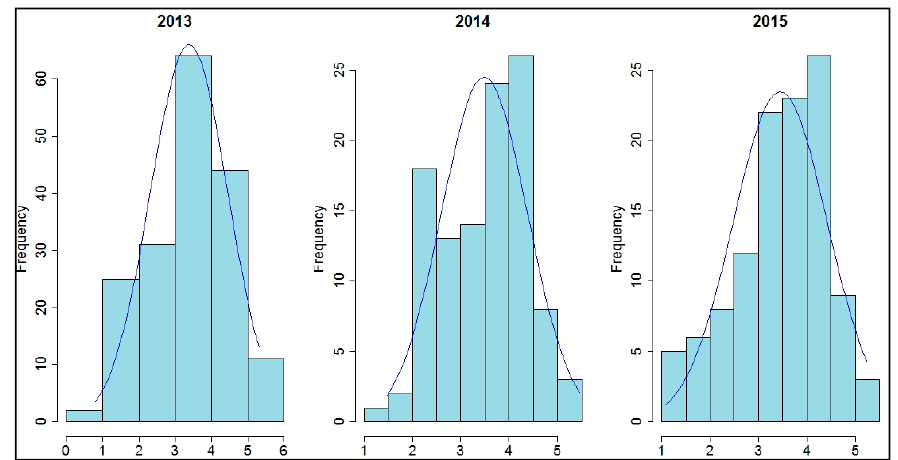
Figure 4. Frequency distributions of natural logarithms of soil Fe for each year. The blue line represents the normal distribution.